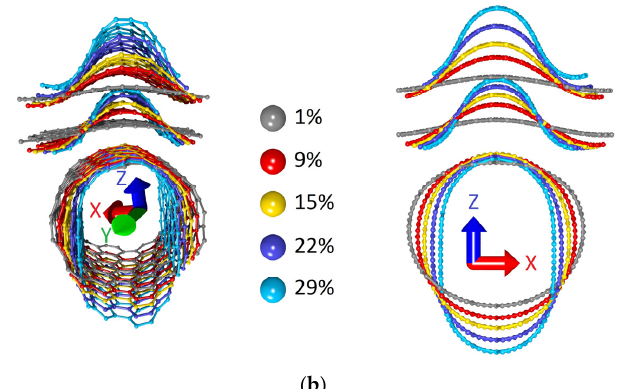
Figure 7. Changes in the atomic network of supercells of bilayer graphene-SWCNT (12,6) hybrid fi lms under axial compression: ( a ) model V1; ( b ) model V2.